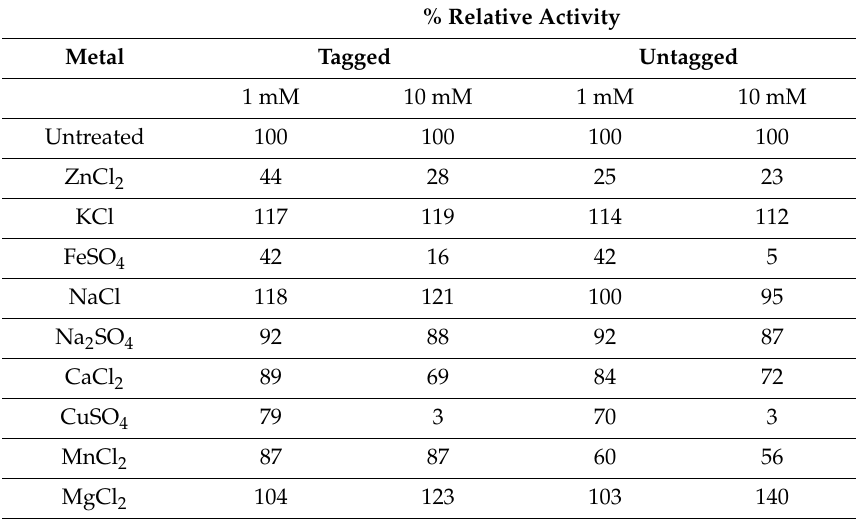
Table 2. Activity of Cp3GT in the presence of various metals. Of the metals tested, ZnCl 2 , NaCl, MnCl 2 , MgCl 2 were significantly di ff erent between tagged and untagged Cp3GT. Values are expressed in % relative activity ( n =